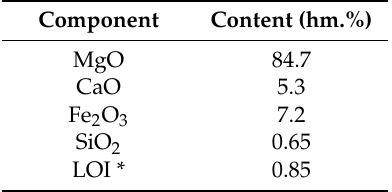
Table 1. Chemical composition of MgO.